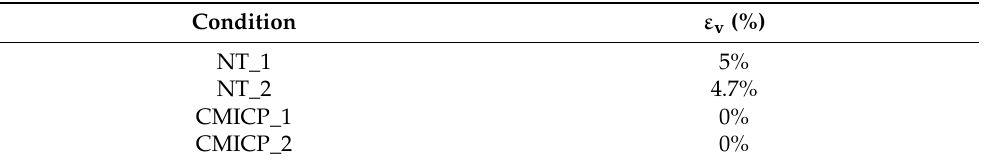
Table 6. Free swelling tests on soils with expansive minerals compacted at 100% of maximum Proctor density.